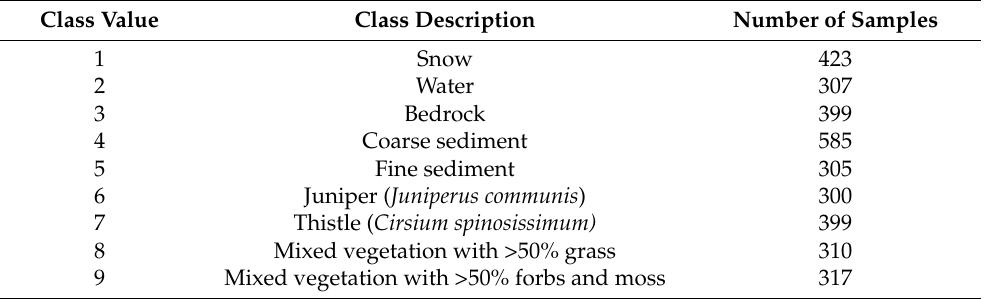
Table 2. Land cover classes and number of ground truthing samples used for the